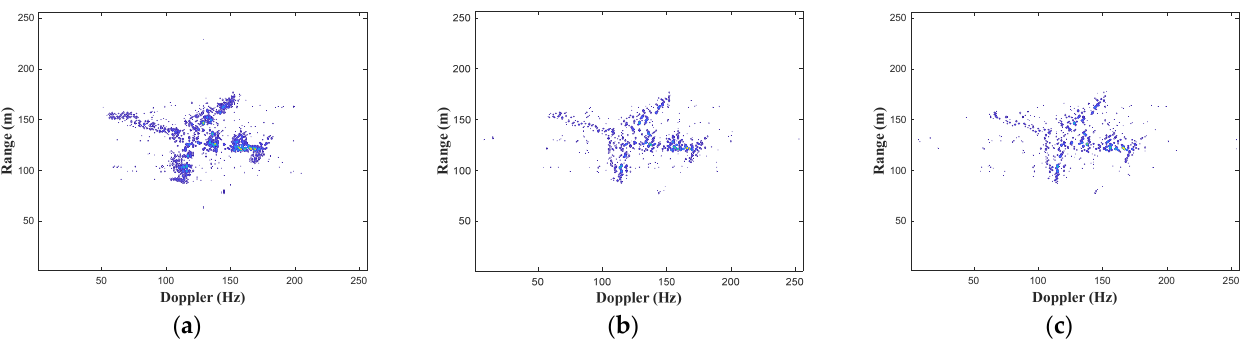
Figure 14. The recovered image using the Relax method. ( a ) 128 pulses. ( b ) 64 pulses. ( c ) 32 pulses. Compared to the recovered images of the three methods, we can see that the KF- tracking method can obtain the high-resolution image of the target in a short observation aperture. However, when the number of the received pulses decreases, some details of the images are getting lost. The KF-tracking can still recover the image of the target and has the least noise